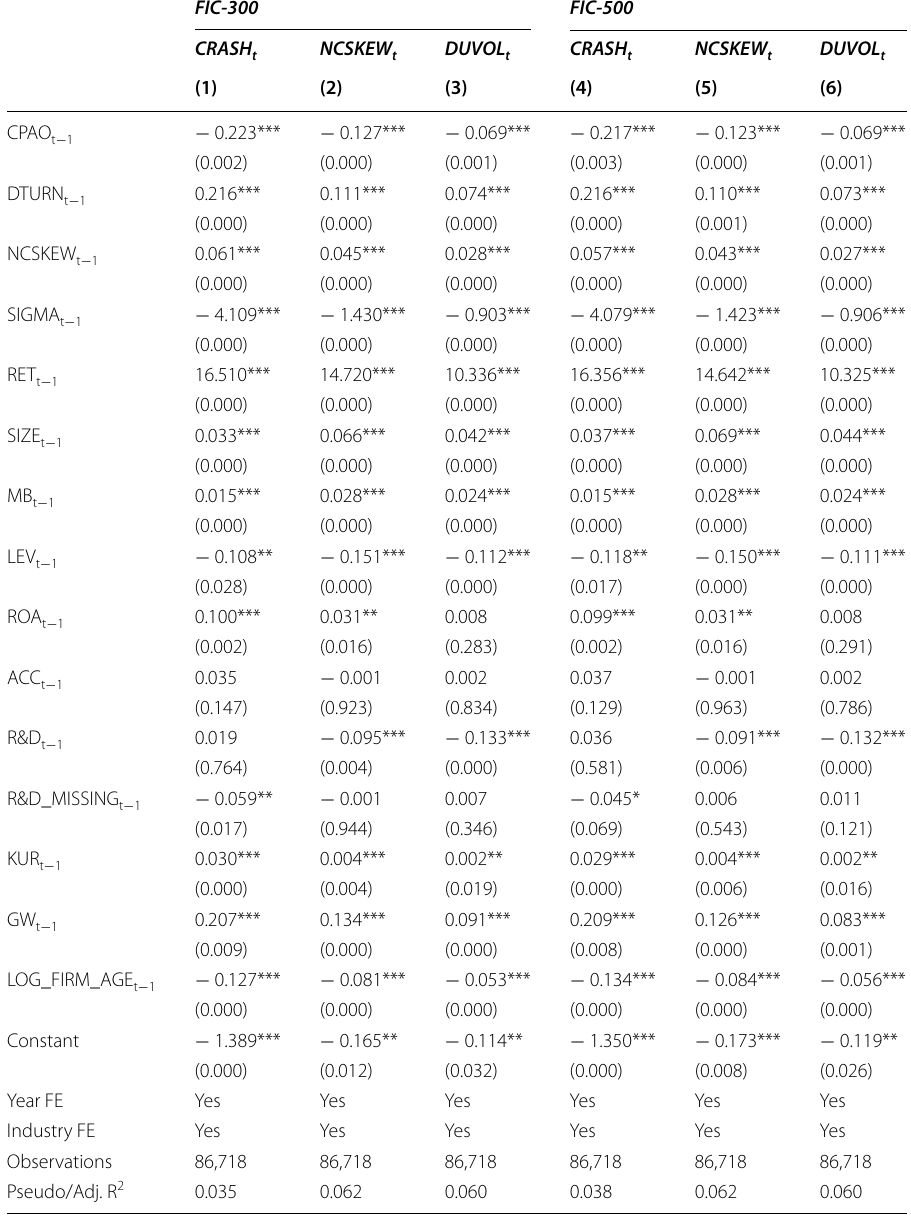
Table 10 Alternative industry fixed effect: 10-K text-based fixed industry